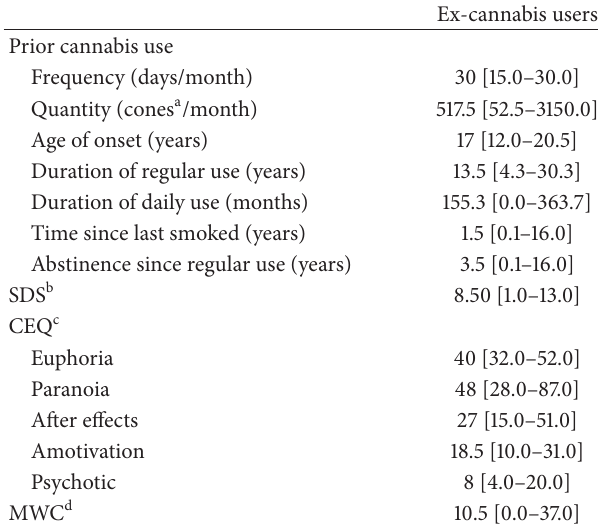
Table 1: Cannabis use measures including abstinence, retrospective measures of dependence and psychological symptoms during intox- ication, and withdrawal